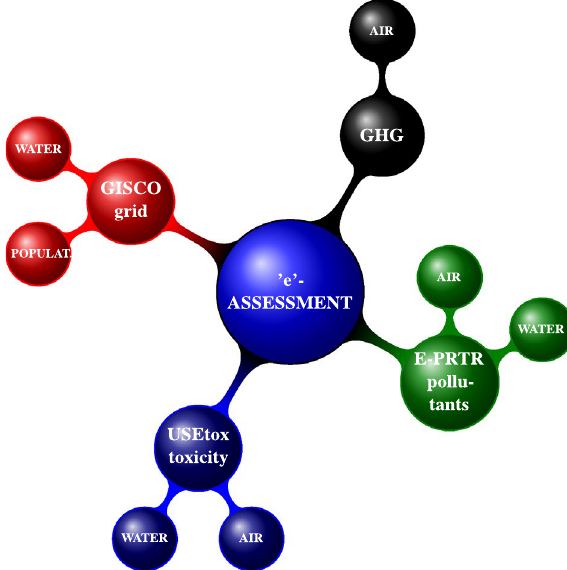
Figure 4. Structure of the environmental assessment.